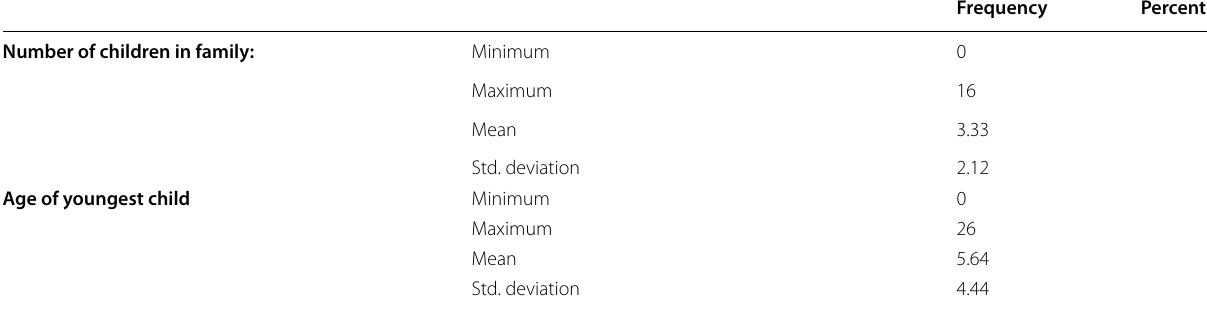
Table 3 The percentage of correct responses to the true or false questionnaire among parents ( n Domain No.